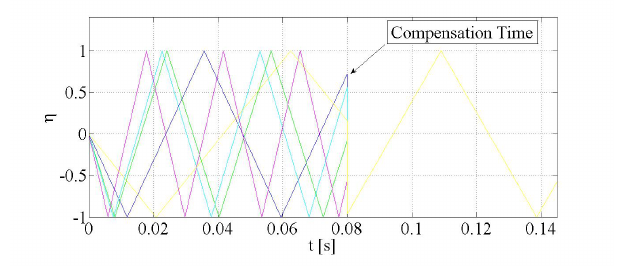
Figure 19. The PWM modulation waveform signals of the six node with decentralized topology, with tdel = 10 − 4 s